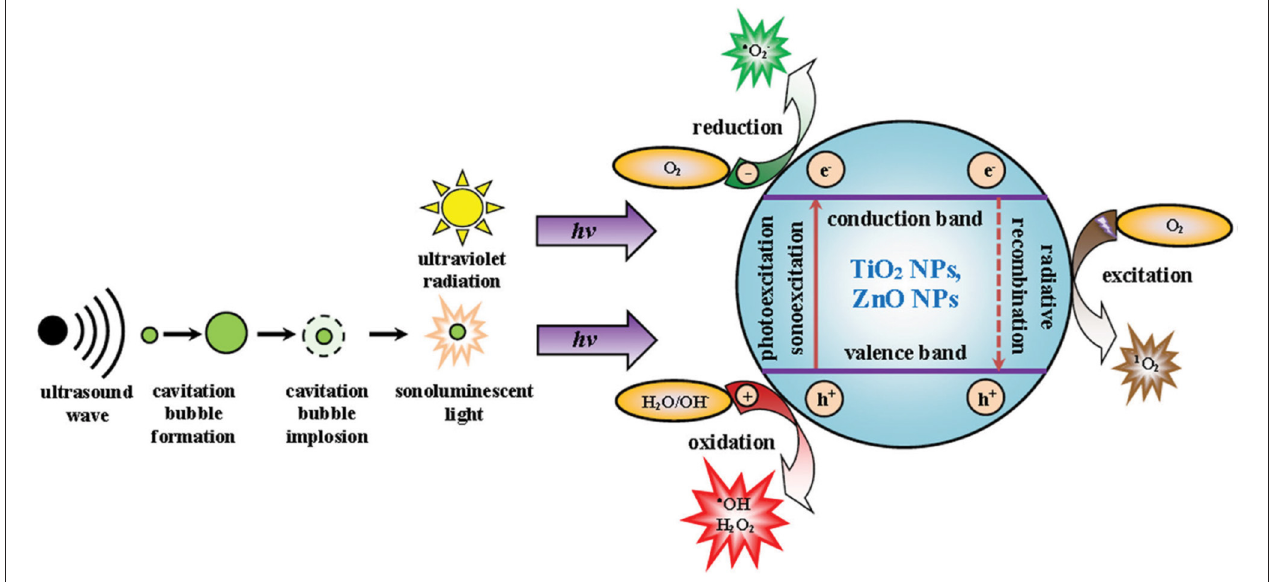
FIGURE 3 | Mechanism of cavitation and ROS production by TiO 2 and ZnO nanoparticles. Reproduced with permission (Bogdan et al., 2017) Copyright © 2017, Springer Nature